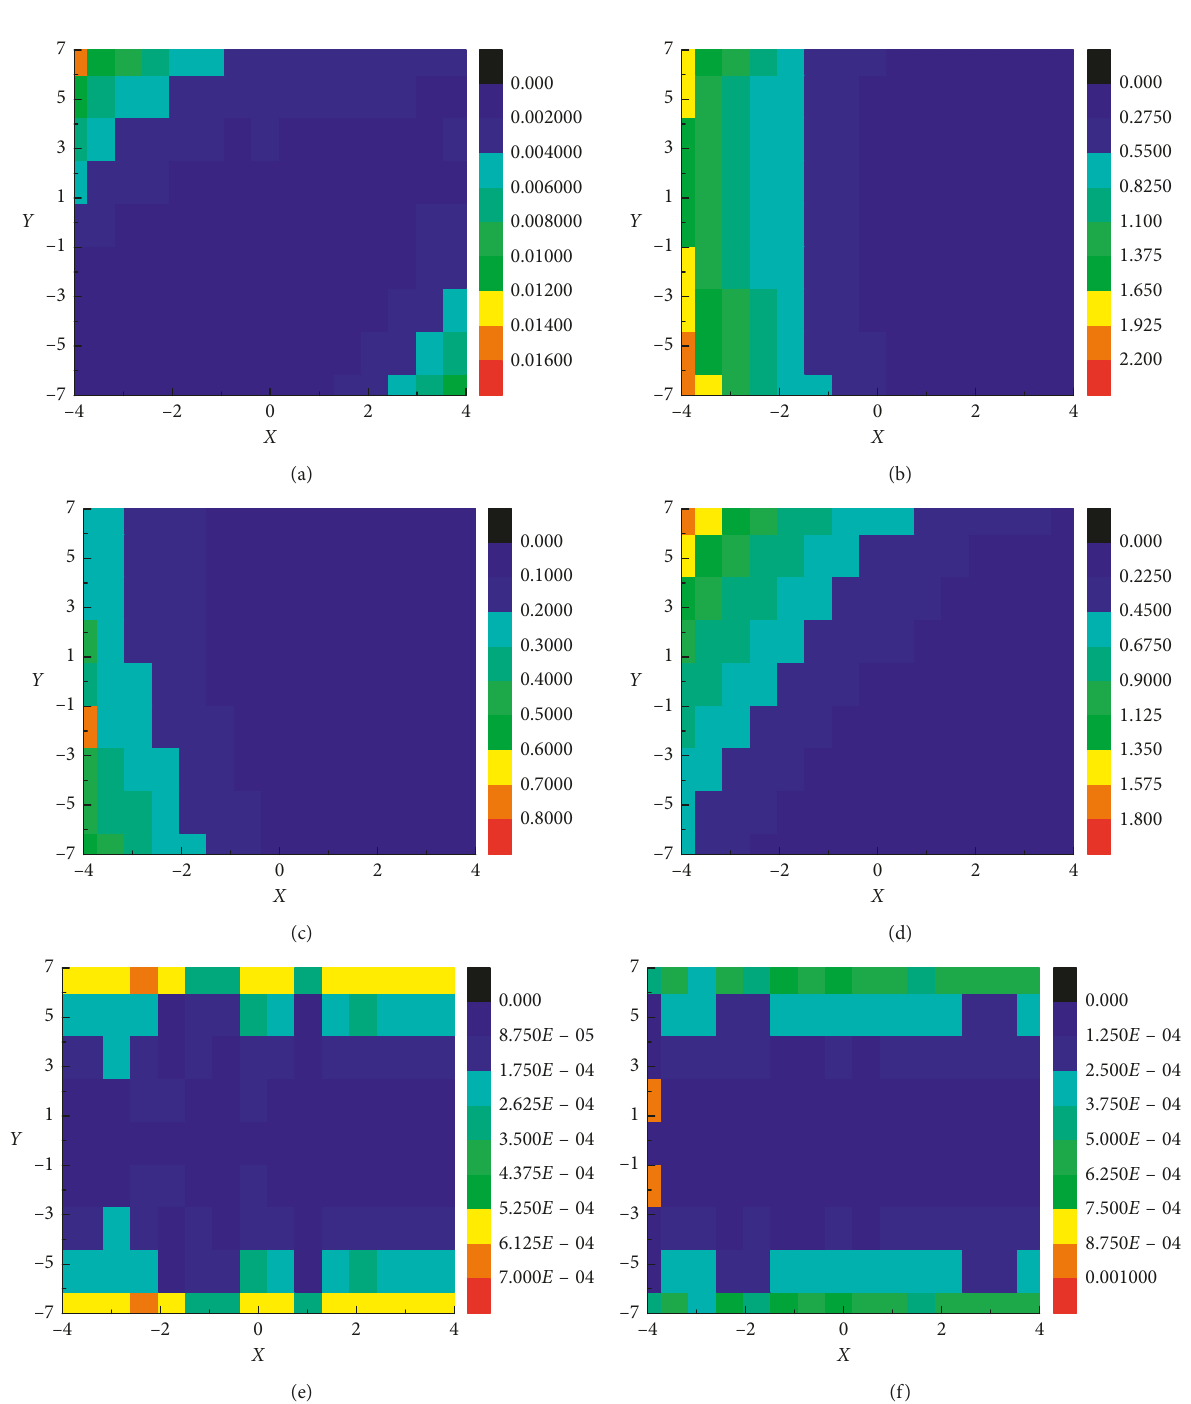
Figure 11: Optimization results under different combinations. (a) Group 1. (b) Group 2. (c) Group 3. (d) Group 4. (e) Group 5. (f) Group